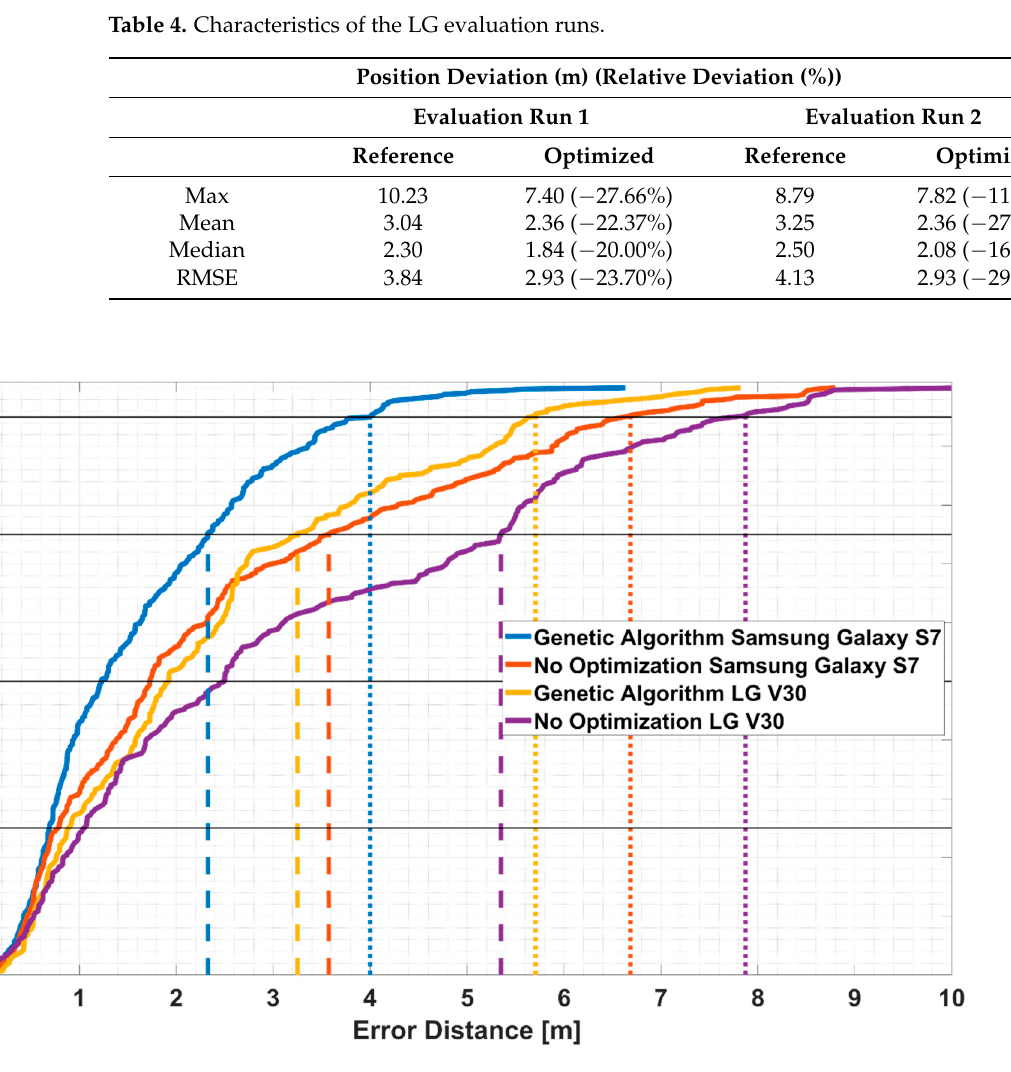
Figure 12. Position deviation of all evaluation runs for the optimized and knowledge-based parameter variants for the corresponding dataset. The red line indicates the median error distances at 1.23 m, 1.73 m, 1.92 m, and 2.50 m. The green line represents the RMSE at 1.98 m, 3.22 m, 2.93 m, and 3.99 m. 8. Conclusions In this work, an algorithm for smartphone-based pedestrian localization was shown, which combines the classical PDR with fingerprinting and a novel multiple hypothesis grid-based interpretation of the particles of the PF. The grid-based representations of the fingerprinting maps and the estimated step length are weighted with the optimization scheme of the GA to achieve higher position accuracy.